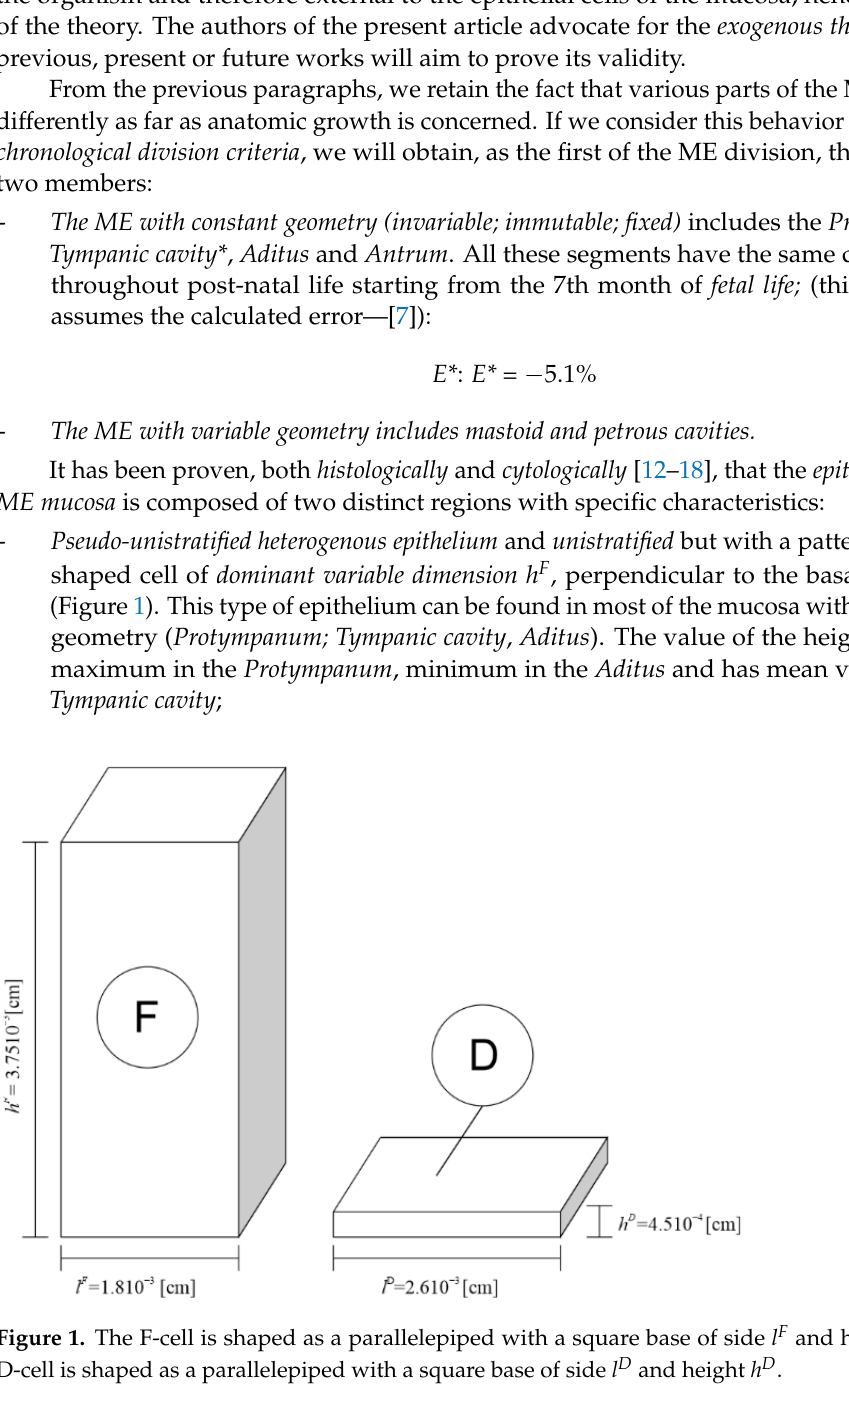
shaped cell of dominant variable dimension h F , perpendicular to the basal membrane